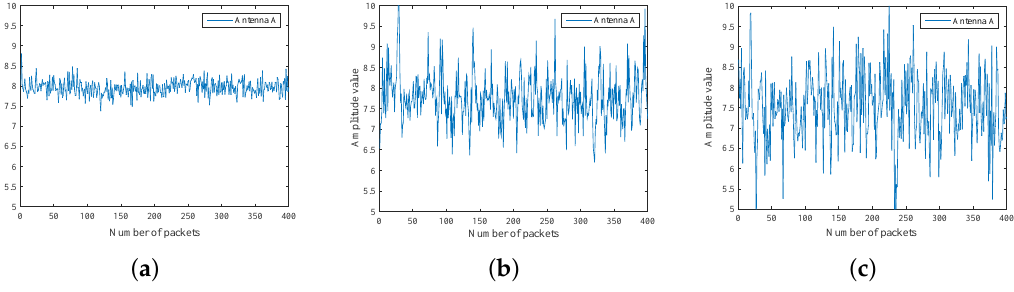
Figure 3. CSI amplitude changes with the people number on one antenna. ( a ) zero people; ( b ) two people; ( c ) four people.